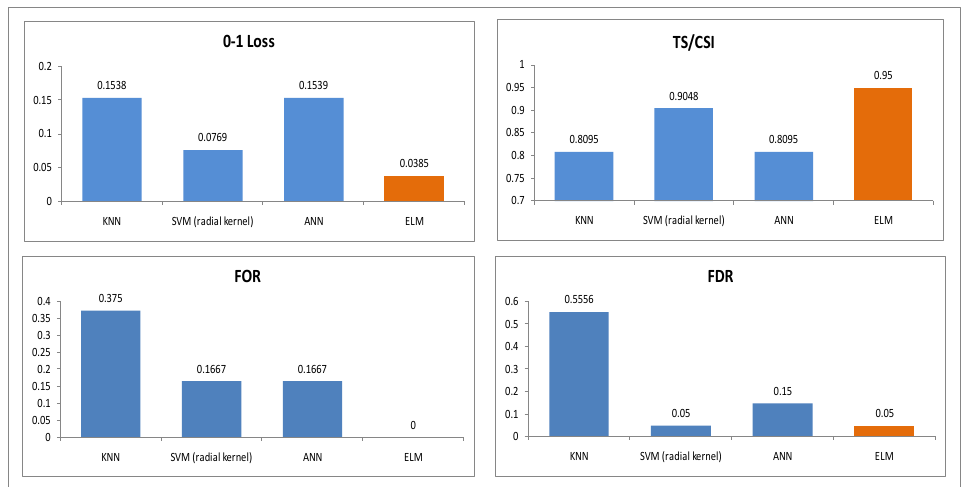
Figure 5. Comparison of algorithms in terms of accuracy